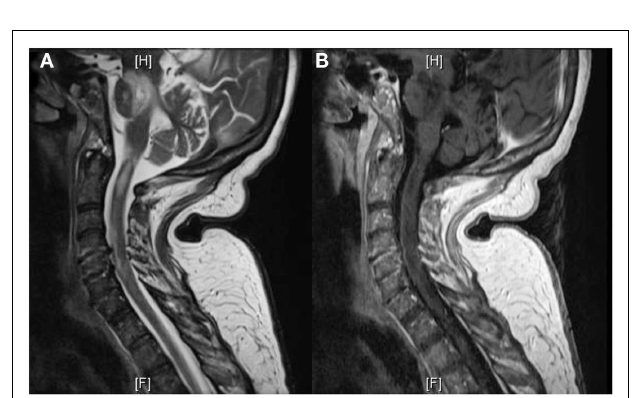
FIGURE 2 | DW-MRI of the brain shows multiple areas of confluent restricted diffusion affecting the splenium of the corpus callosum, right medial occipital white matter, right brachium pontis, bilateral dorsal